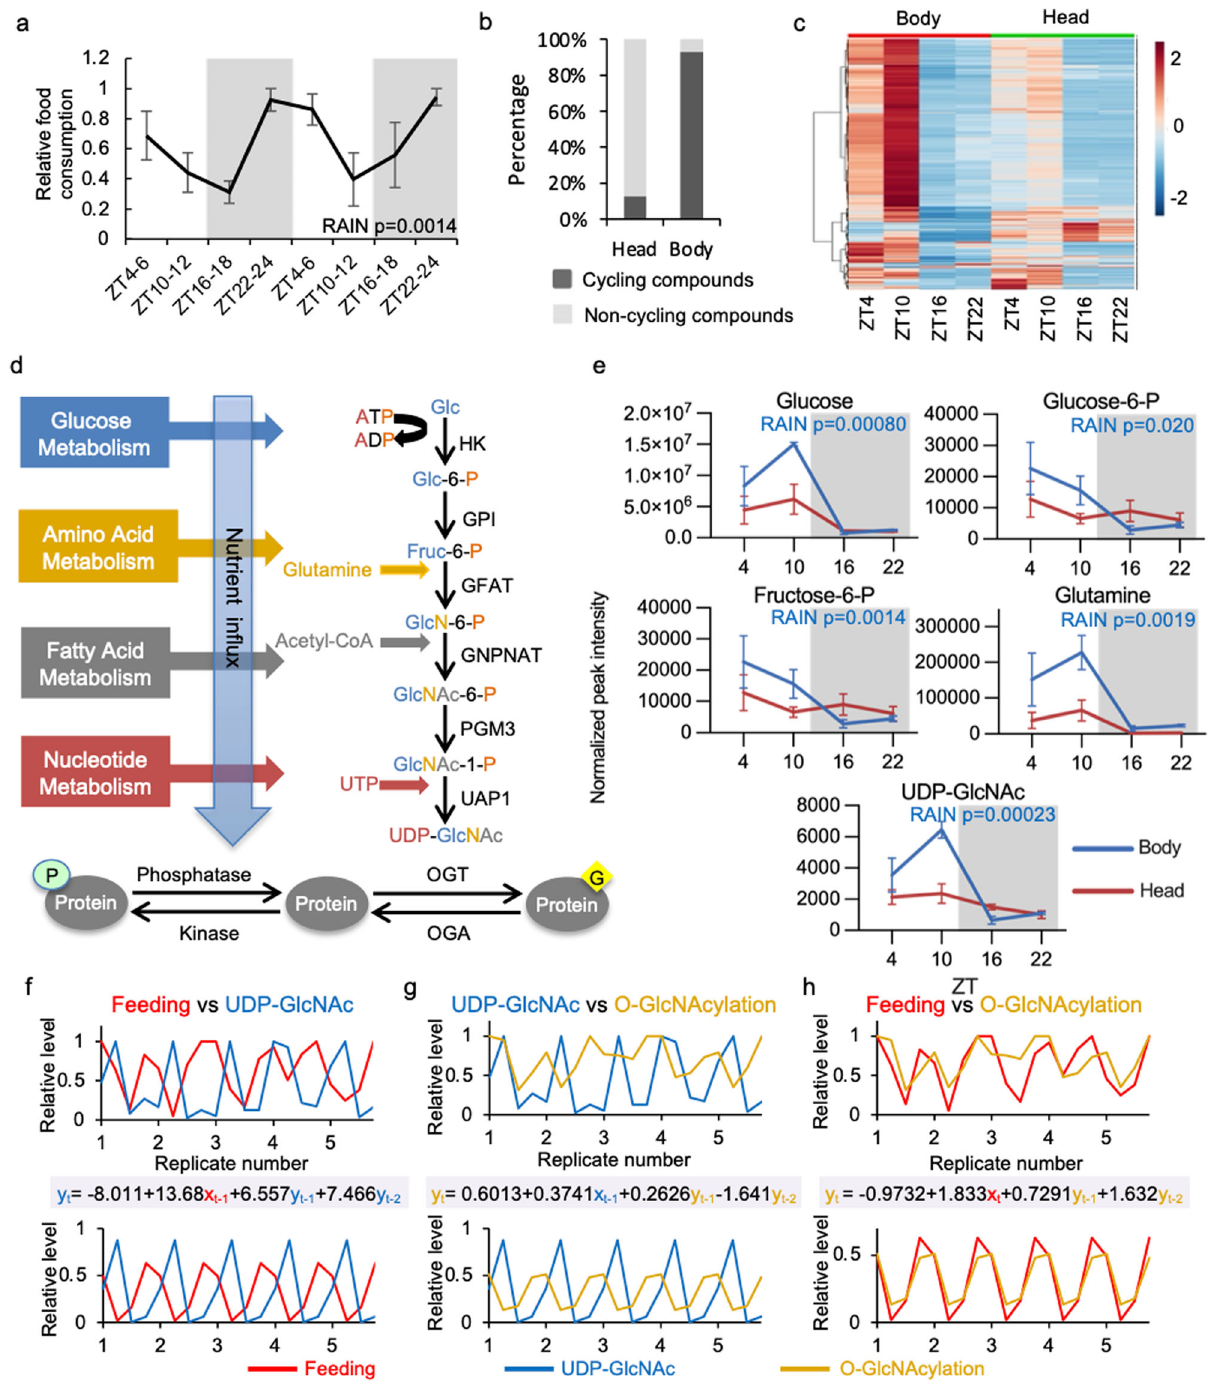
(Fig. 3d third panel from top and f). On one hand, results